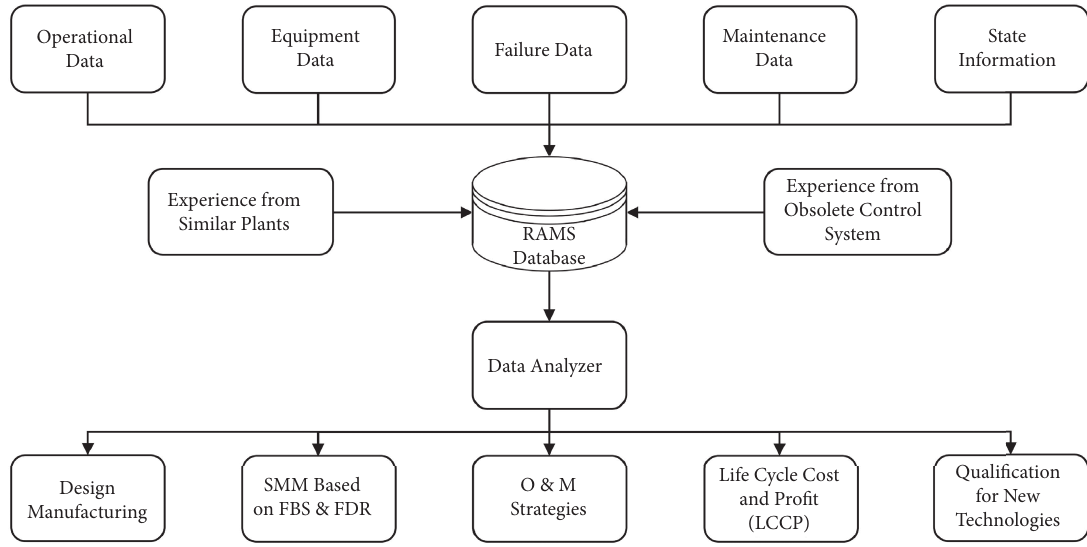
Figure 6: Schematic of proposed RAMS database. Table 1: Rating scale of linguistic variables and triangular fuzzy number